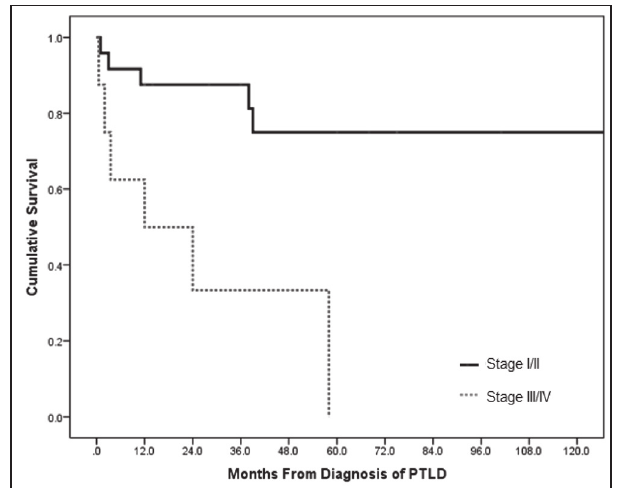
Figure 5) Kaplan-Meier curve comparing the one-, three- and five-year survival in stage I/II post-transplant lymphoproliferative disorder (PTLD) compared with with stage III/IV